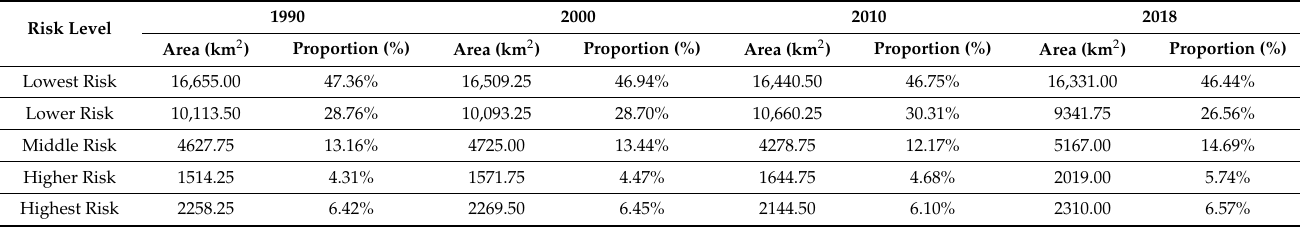
Table 4. The area and proportion of different risk levels from 1990 to